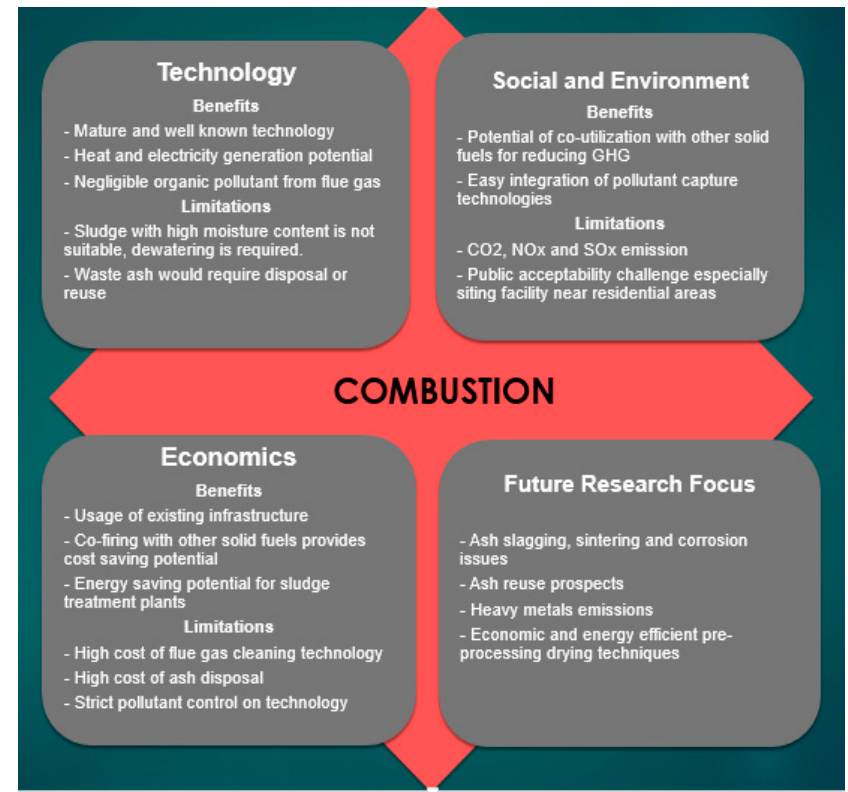
Figure 6. Technological, Socio-environmental and Economic Assessment of Combustion for Sludge